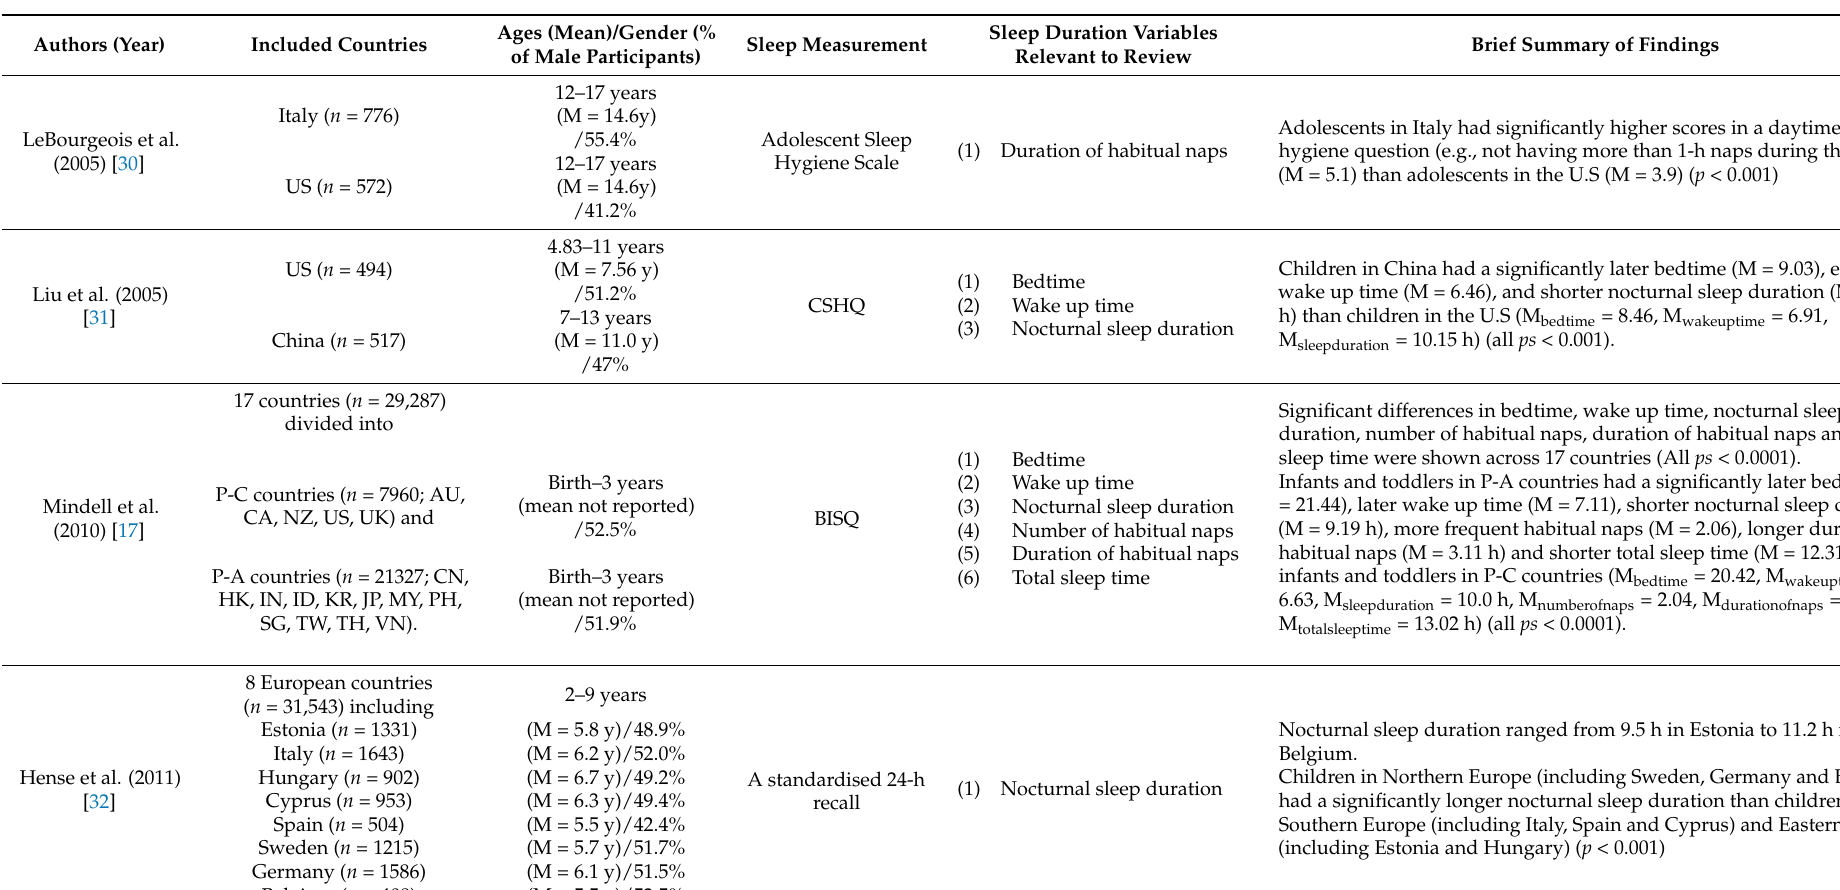
Table 1. Characteristics of included studies relating to sleep duration